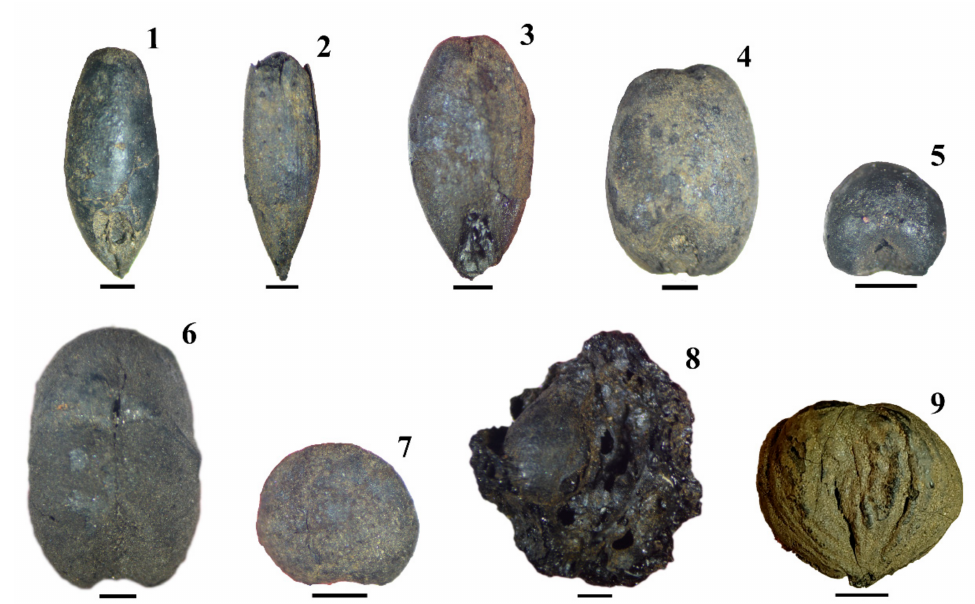
Figure 5. Some of the fruits/seeds found at SB: 1—rye grain; 2— Hulled grain of oat; 3—barley grain with husk remains still attached; 4—naked wheat grain; 5—broomcorn millet grain; 6—faba bean seed; 7—lentil seed; 8—berry and pip of grape; 9—chestnut fruit. With the exception of chestnut (5mm scale), all remains show a 1 mm